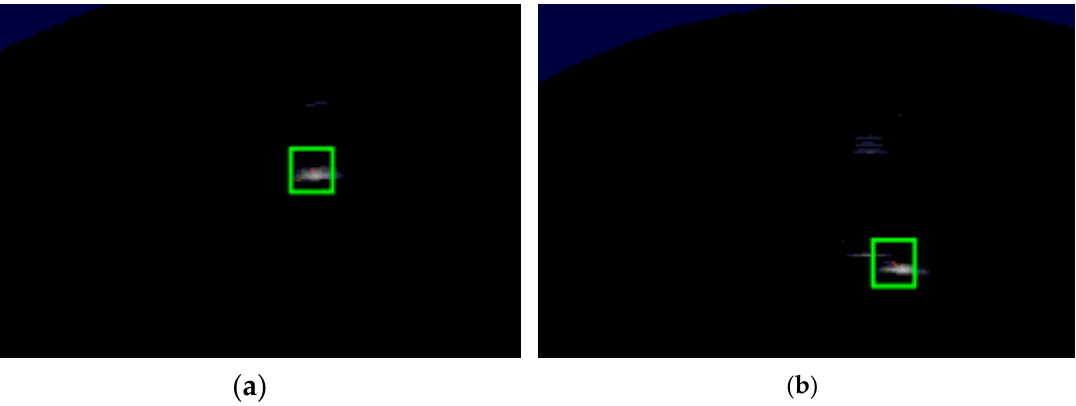
Figure 12. Tracking results obtained by presented method in ( a ) (p + 1)th image and ( b ) (p + 2)th image.